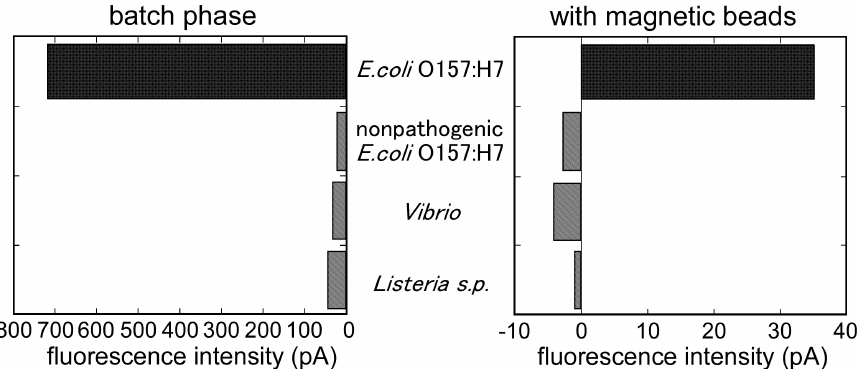
Figure 5. Signal comparison between E. coli O157:H7 and other bacteria. The left is the fluorometric output for each bacteria in the batch phase immunoassay. The concentrations of bacteria are 1.0 × 10 5 cells/mL. The right is the fluorometric output for each bacterium in the magnetic bead attach/release immunoassay. (Concentrations of bacteria are 1.0 × 10 7 cells/mL).